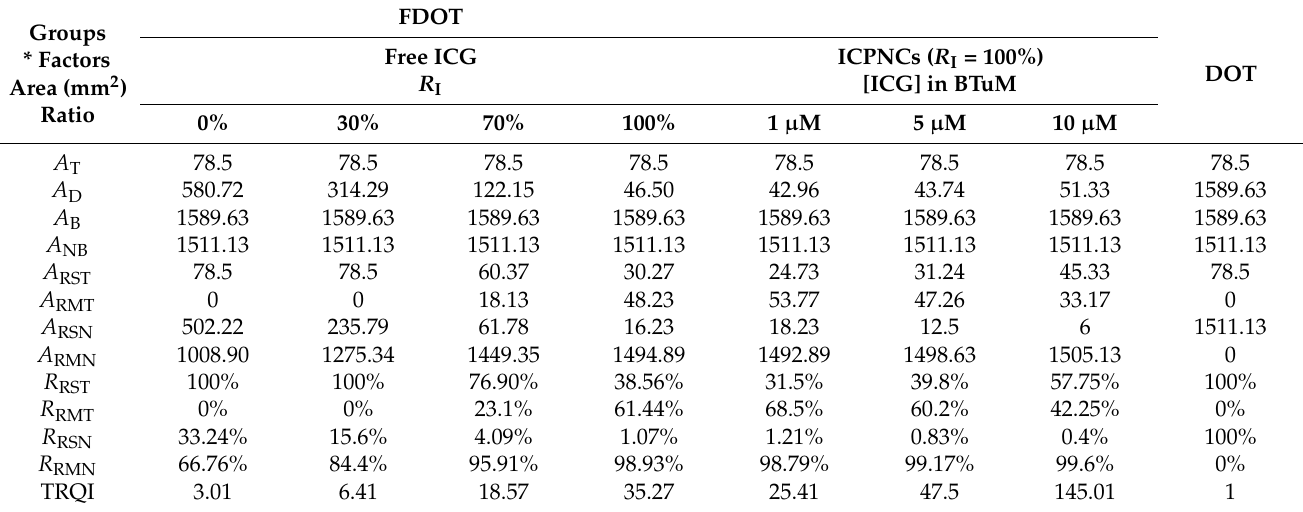
Table 3. Effect of FDOT detection using free ICG or ICPNCs as the NIR contrast agent in the phantom.